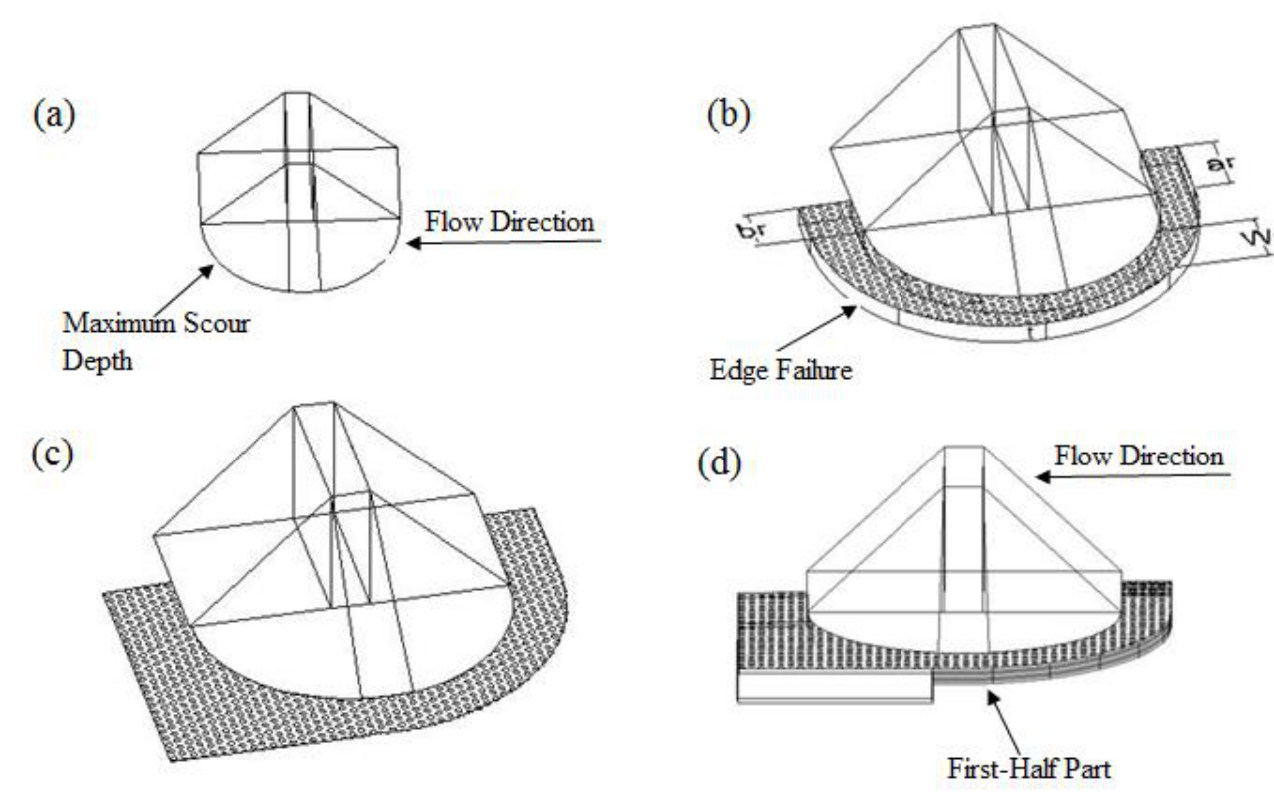
Figure 7. Geometry of riprap particle in spill-through abutment: ( a ) location of maximum scour depth ( b ) Geometry I, T 19 ; ( c ) Geometry II, T 20 ; ( d ) shape of apron with 1.5 D R 50 , T 22 . (flow from right to left).